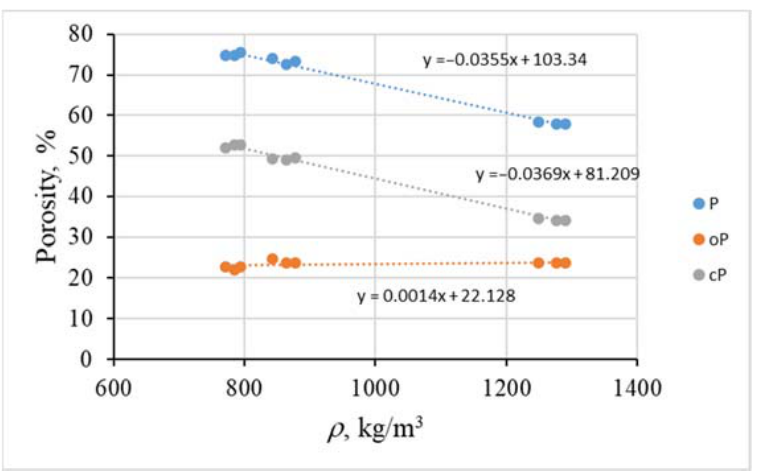
Figure 4. The kinetics of water absorption for lightweight aggregate shotcrete samples.